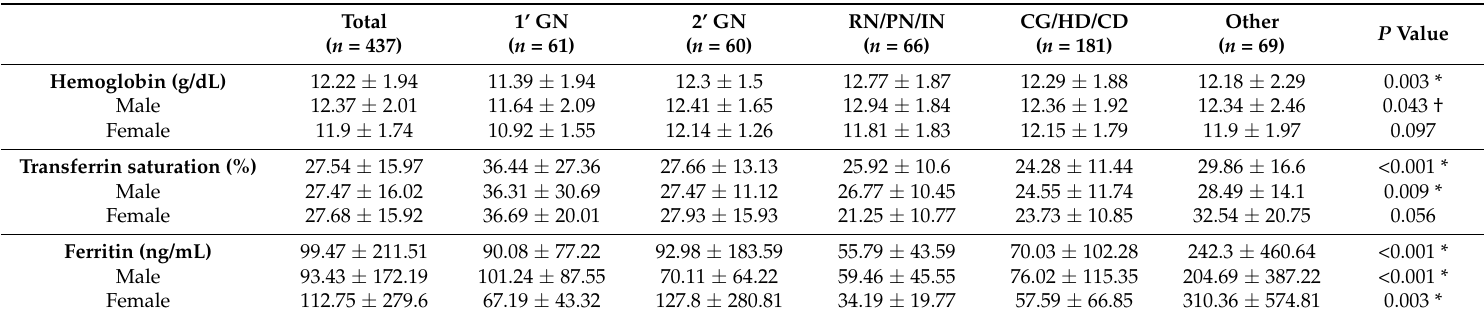
Table 5. Hemoglobin, transferrin saturation, and ferritin levels stratified by disease preceding CKD.